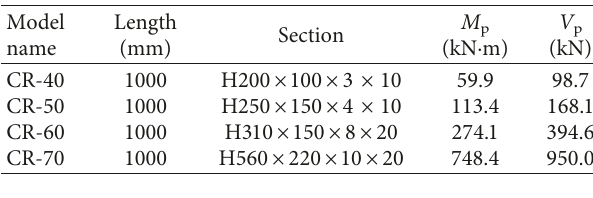
Figure 6: Plan view of the structure. Table 1: Properties of coupling beam.